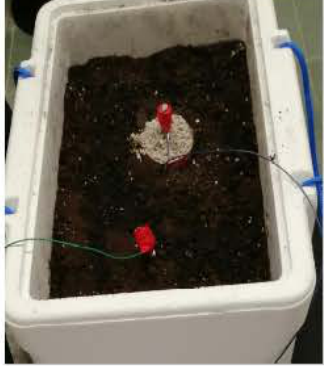
Figure 15. Case 3: The aluminum container filled with cat